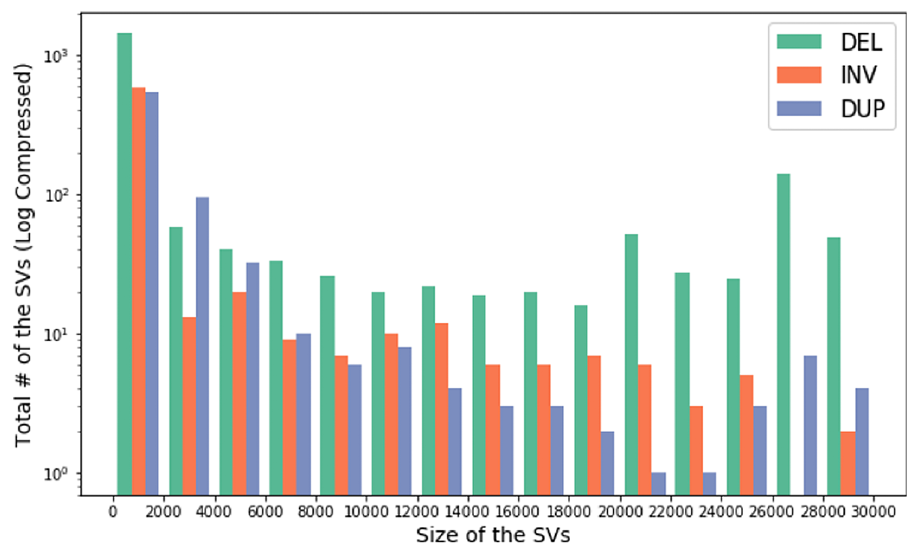
Figure 13. An analysis of size and number of identified SARS-CoV-2 SVs. Histogram showing size of the SVs and the total number of SVs across multiple Nanopore and Illumina datasets. The y-axis of the histogram is log compressed.